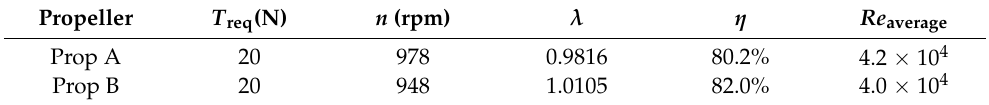
Table 5. Comparison between two optimized propellers at the design